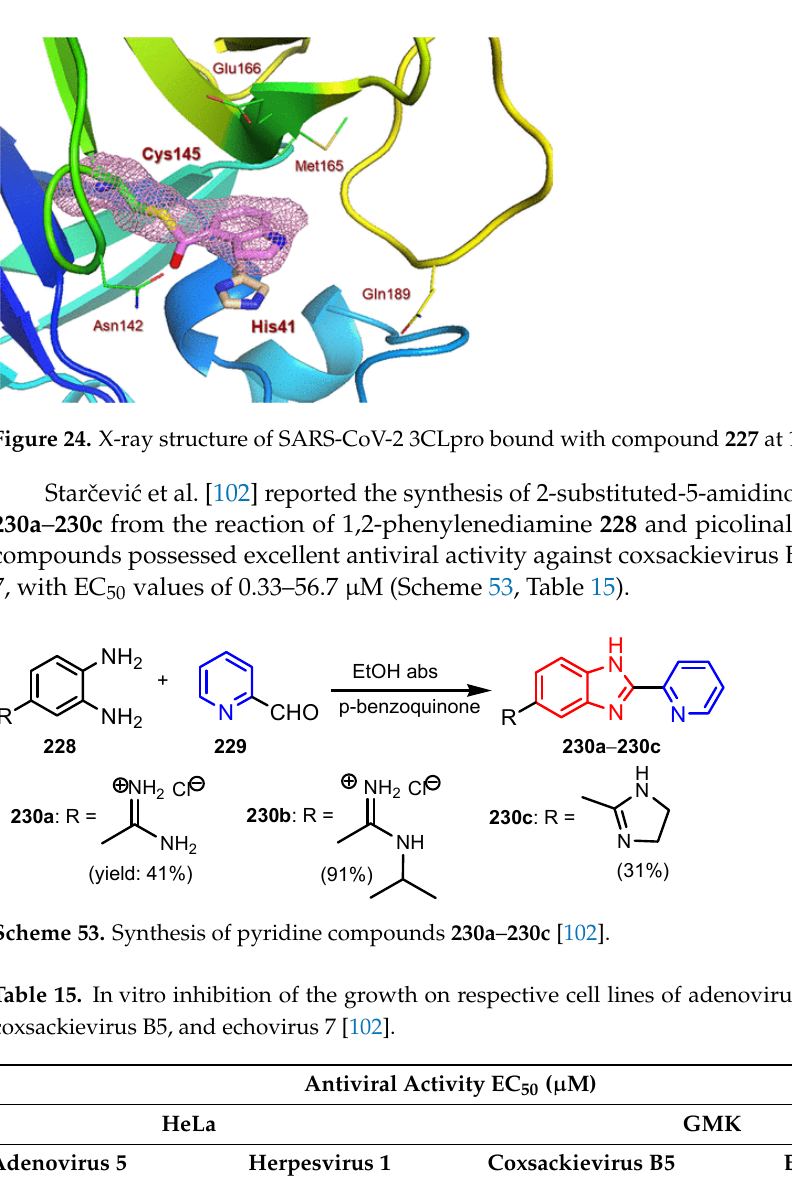
Scheme 52. Synthesis of pyridine compound 227 [101].